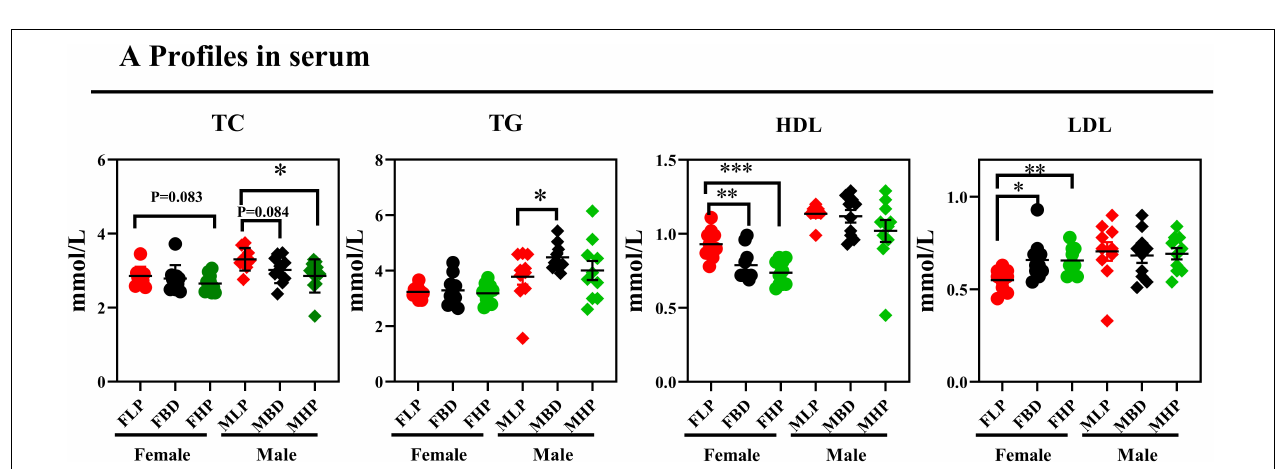
FIGURE 2 | Effects of diets with different protein levels on serum lipid levels in